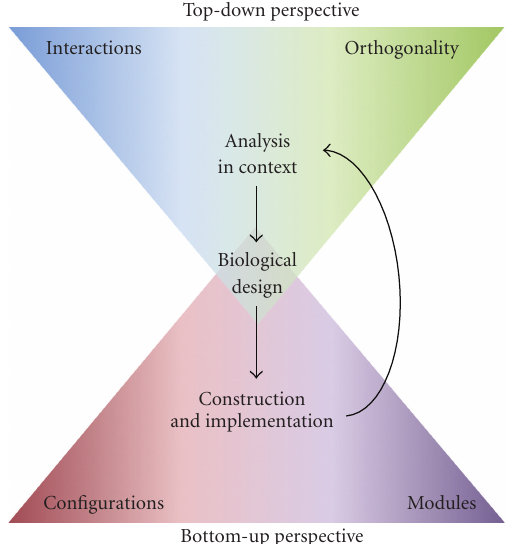
Figure 1: General conceptual framework for incorporating top-